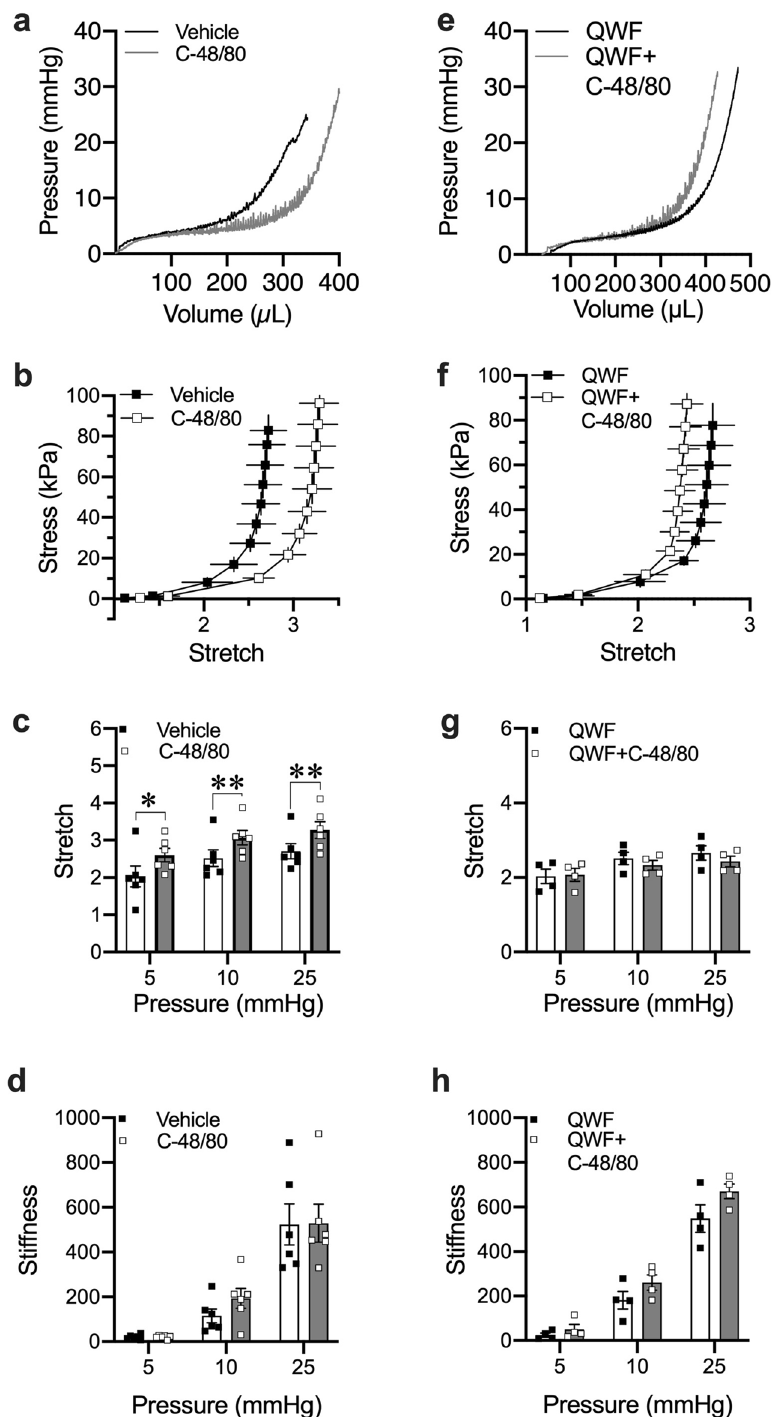
Figure 4. Compound 48/80 increases bladder wall compliance independent of mast cells. ( a ) Representative pressure–volume trace of ex vivo filling of C-Kit W-Sh mouse bladders in the absence and presence of the Mrgprb2 agonist Compound 48/80 alone (10 µg/mL) ( e ) representative pressure–volume trace after prior exposure to the Mrgprb2 antagonist QWF (10 µM). ( b , c ) As with C57Bl/6 mice, compliance is increased in the presence of C-48/80 in mast cell-deficient C-Kit W-Sh mice (N = 6) signified by the increase in stretch ( P = 0.01, P = 0.006 and P = 0.008 for vehicle vs. C-48/80) at 5, 10, and 25 mmHg respectively. ( f , g ) The increase in compliance by C-48/80 was again blocked by QWF (N = 4) signified by the overlapping stress-stretch curves and no increase in stretch (P = 0.343, P = 0.255 and P = 0.282 for 5, 10 and 25 mmHg respectively for QWF vs. QWF + C-48/80). ( d , h ) similar to wild-type, stiffness remains unchanged. Within the group comparisons were made via two- tailed, paired Student’s t-test. “C-48/80”: 10 µg/mL Compound 48/80; “QWF”: 10 µM